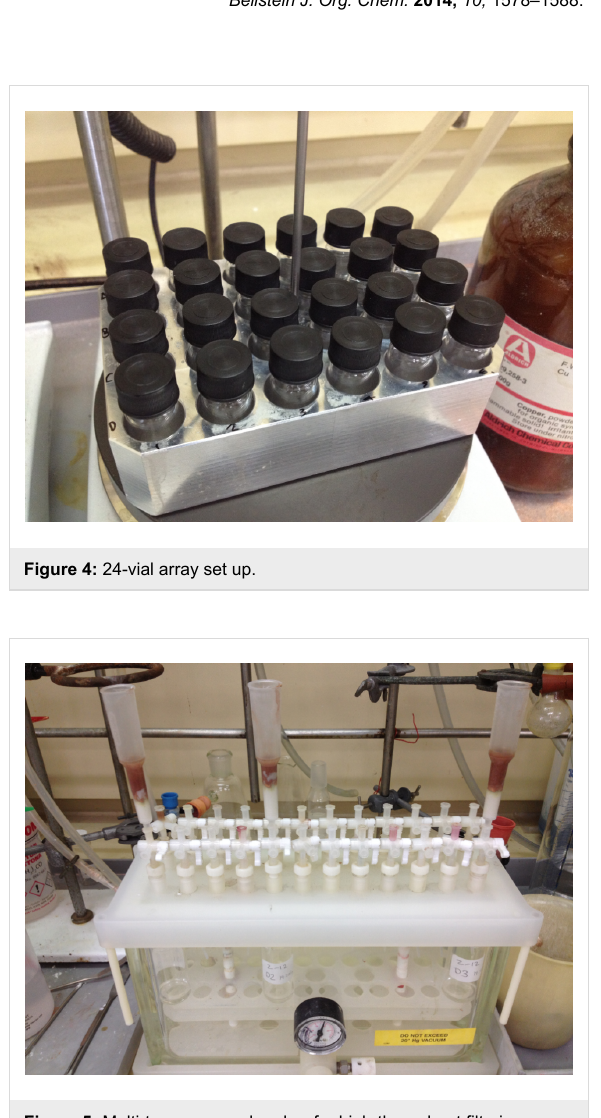
Figure 5: Multi-tap vacuum chamber for high-throughput